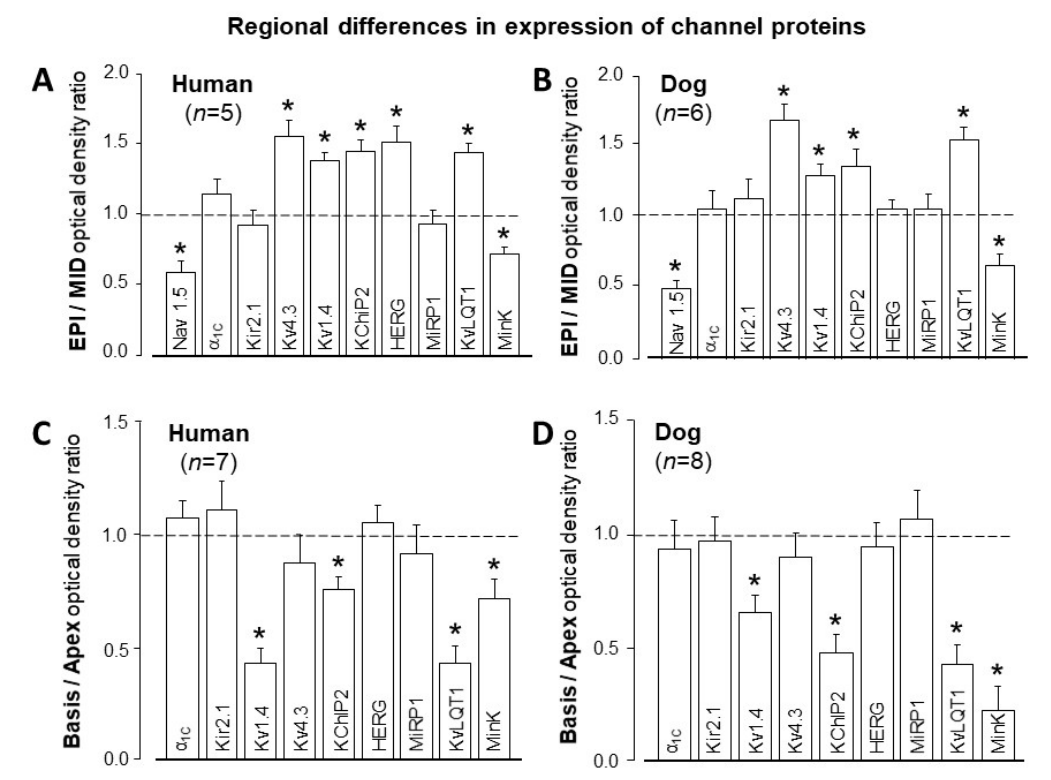
Figure 7. Regional inhomogeneity of the channel protein expression pattern in human and canine ventricular myocardium. ( A , B ) Epicardial versus midmyocardial distribution. ( C , D ) Apical versus basal distribution. Columns and bars are mean ± SEM values, ( n ) denotes the number of myocardial samples studied, the asterisks (*) indicate significant differences from the ratio of 1. (Data from references